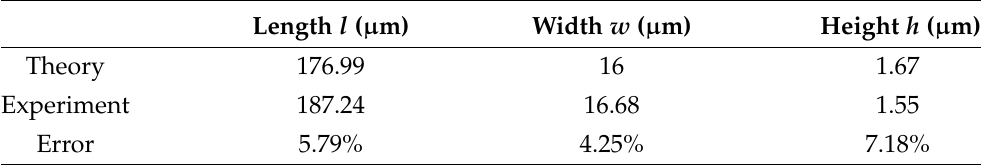
Table 5. The secondary structure size fabricated in the